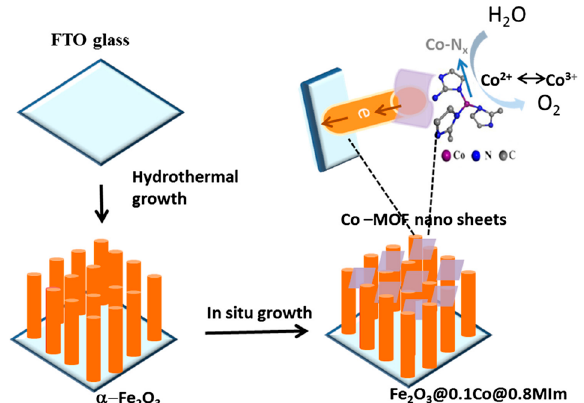
Figure 7. Scheme representing photoelectrocatalytic water oxidation on Co-MOF nanosheets as catalyst and α -Fe 2 O 3 hematite as photoanodes grown on FTO (F:SnO 2 ) (Reprinted with the permission [111]. Copyright 2018 Elsevier).